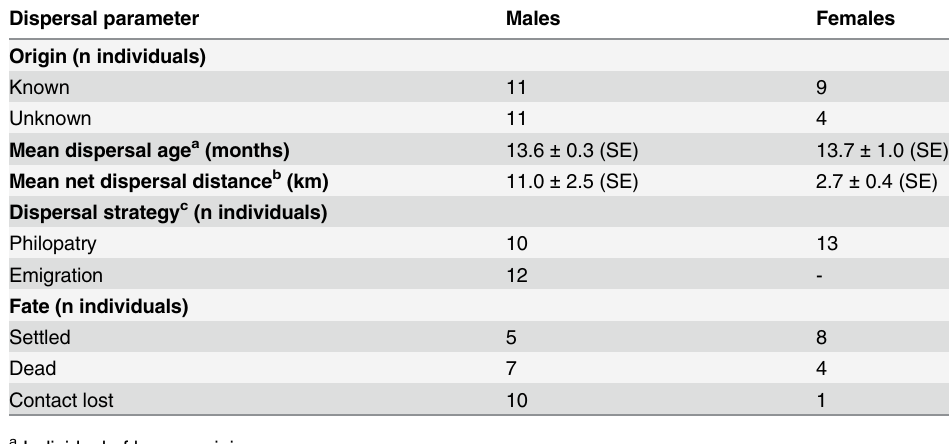
Table 1. Summary statistics of the dispersal parameters for 35 subadult leopards in Phinda Private Game Reserve, South Africa, 2002 – 2012.